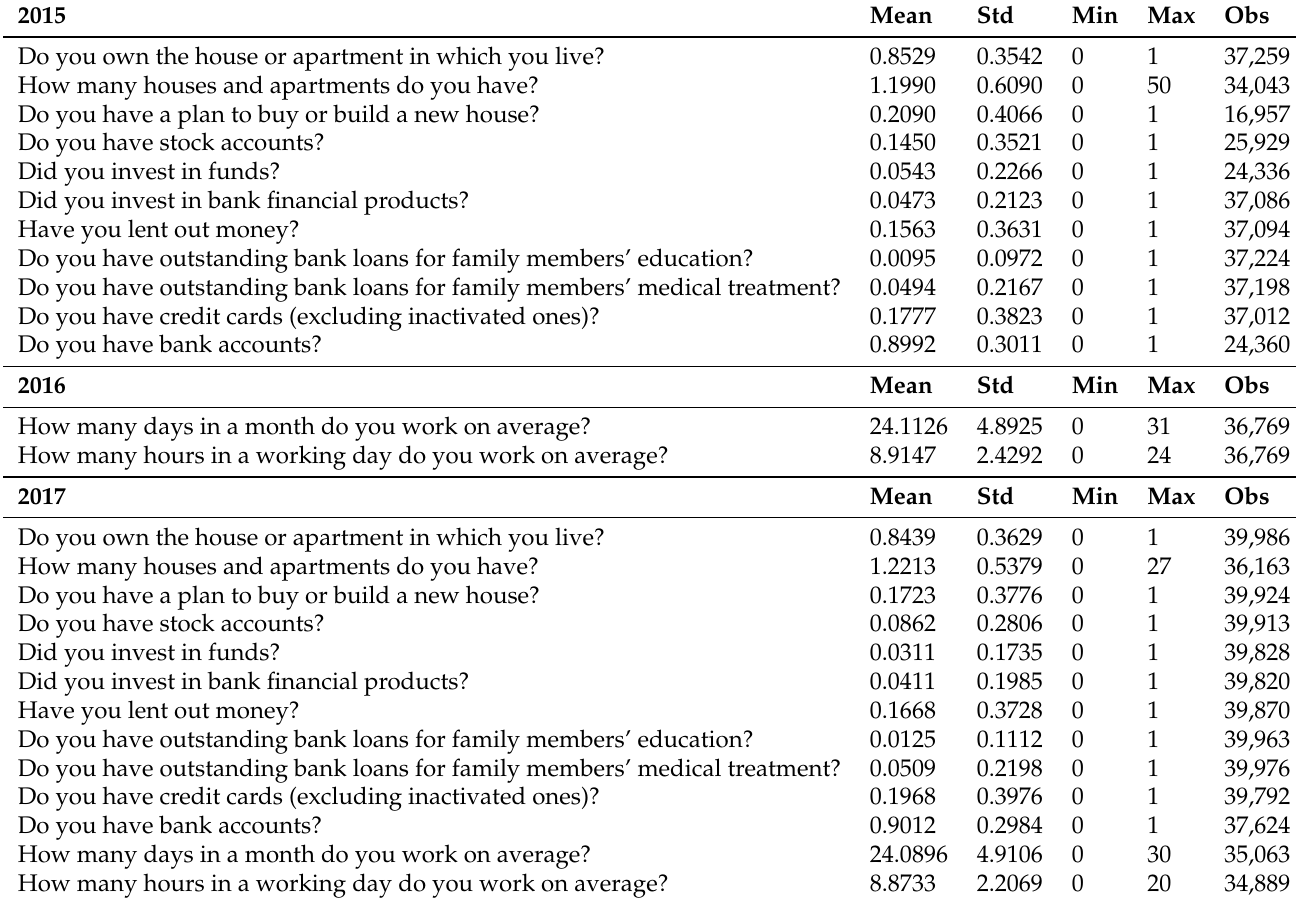
Table 1. Descriptive statistics of outcome variables of